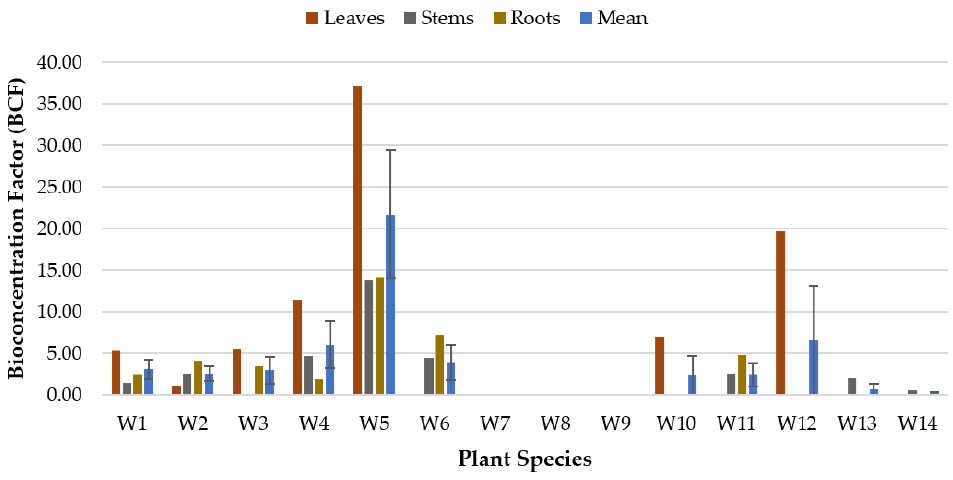
Figure 6. Bioconcentration Factor (BCF) of Manganese (Mn) in phytoremediation of domestic sewage mesocosms using various tropical